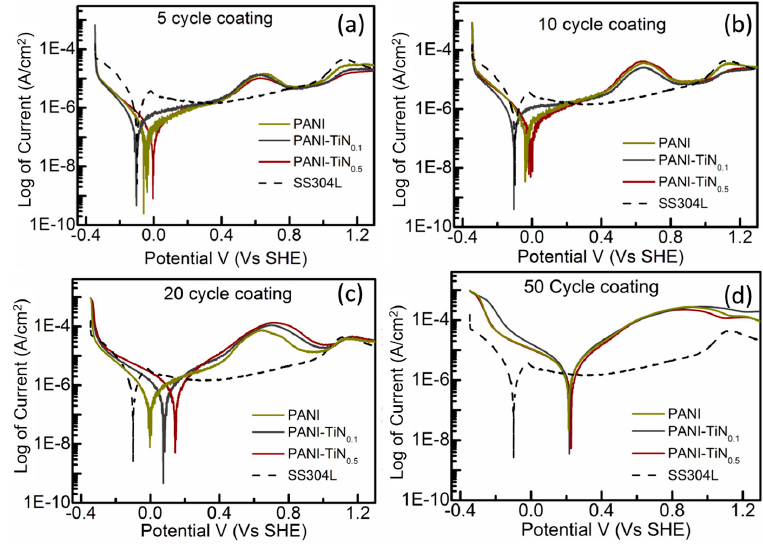
Figure 4. Potentiodynamic polarisation curves recorded in 1 mM H 2 SO 4 at 80 °C for ( a ) five cycle, ( b ) 10 cycle, ( c ) 20 cycle, and ( d ) 50 cycle coatings. ( b ) 10 cycle, ( c ) 20 cycle, and ( d ) 50 cycle